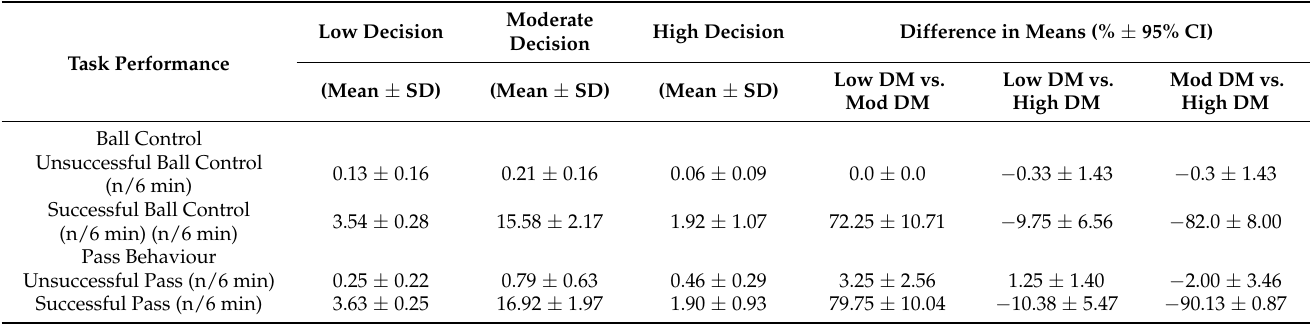
Table 1. Descriptive (M ± DP) statistics from the intervention tasks (Low DM, Mod DM, and High DM).